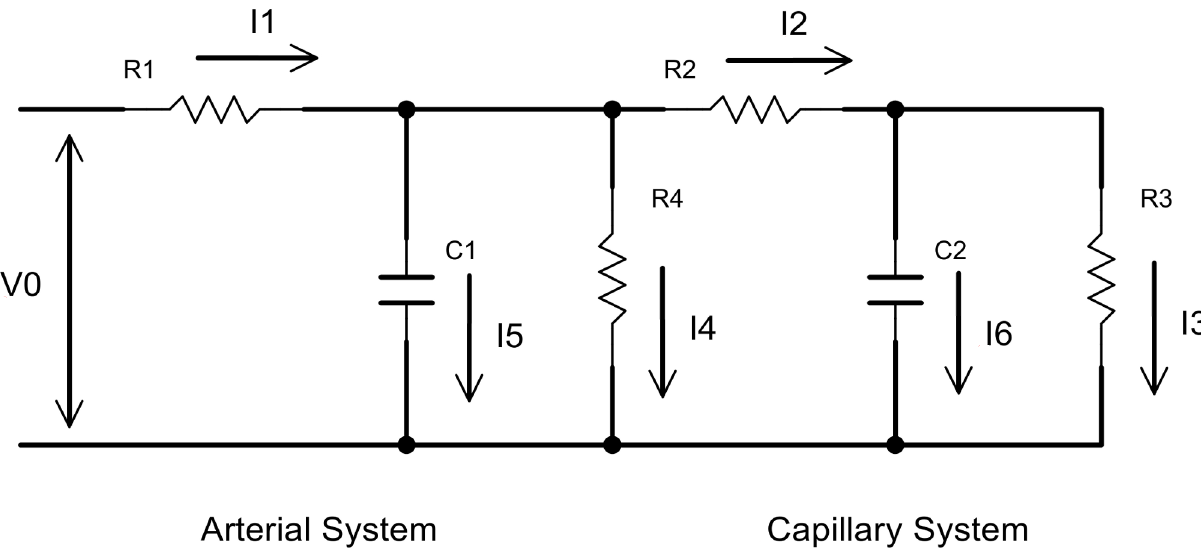
Figure 3. Circuit model of the blood flow. R (resistance) represents vascular resistance, C (capacitance) represents vessel compliance, V ( t ) represents the input blood flow pressure, and I (current) represents blood flow. I 2 ( t ) represents the skin blood flow.